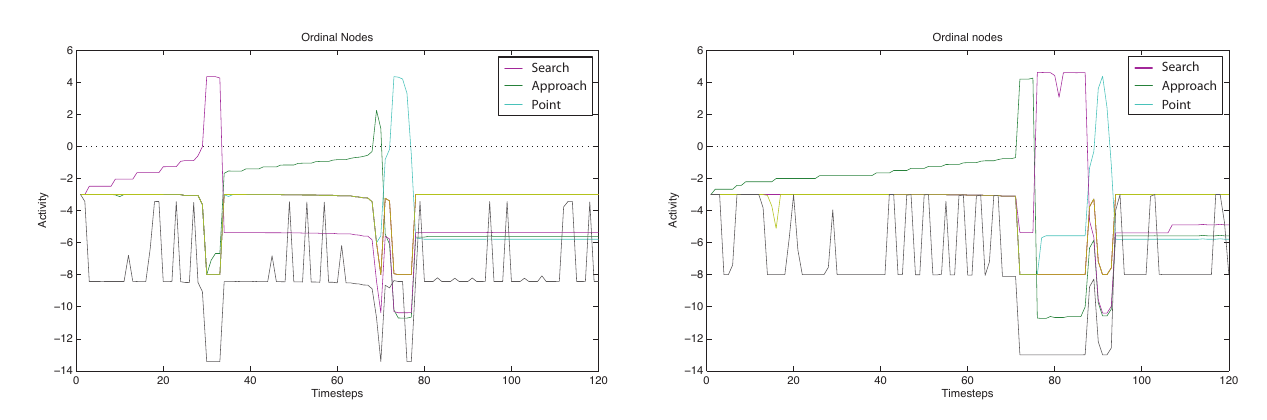
Figure 6. Activityofordinalnodesforallelementarybehaviorswhenthe Search behavior is explored first.